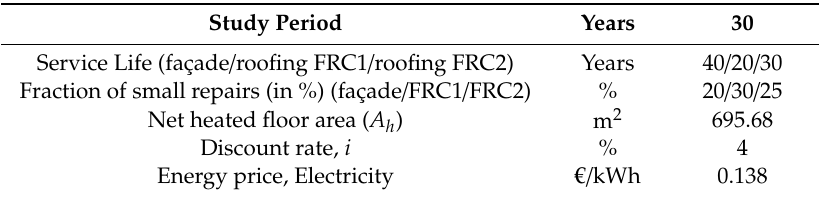
Table 4. Starting points of the economic